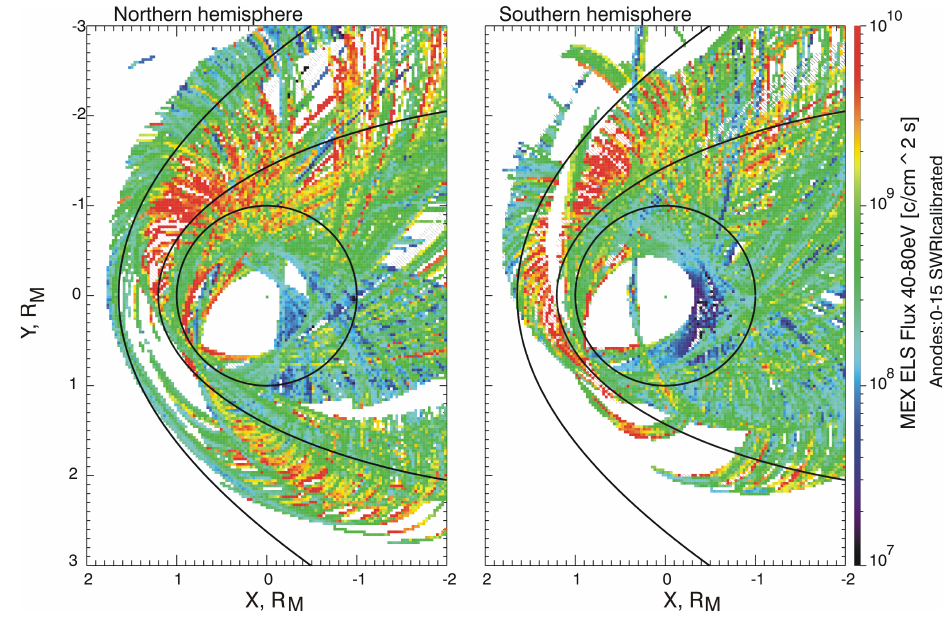
Fig. 10. Map of median electron fluxes (40eV <E< 80eV) in the XY (MSO) noon-midnight planes for the Southern and Northern Hemi-